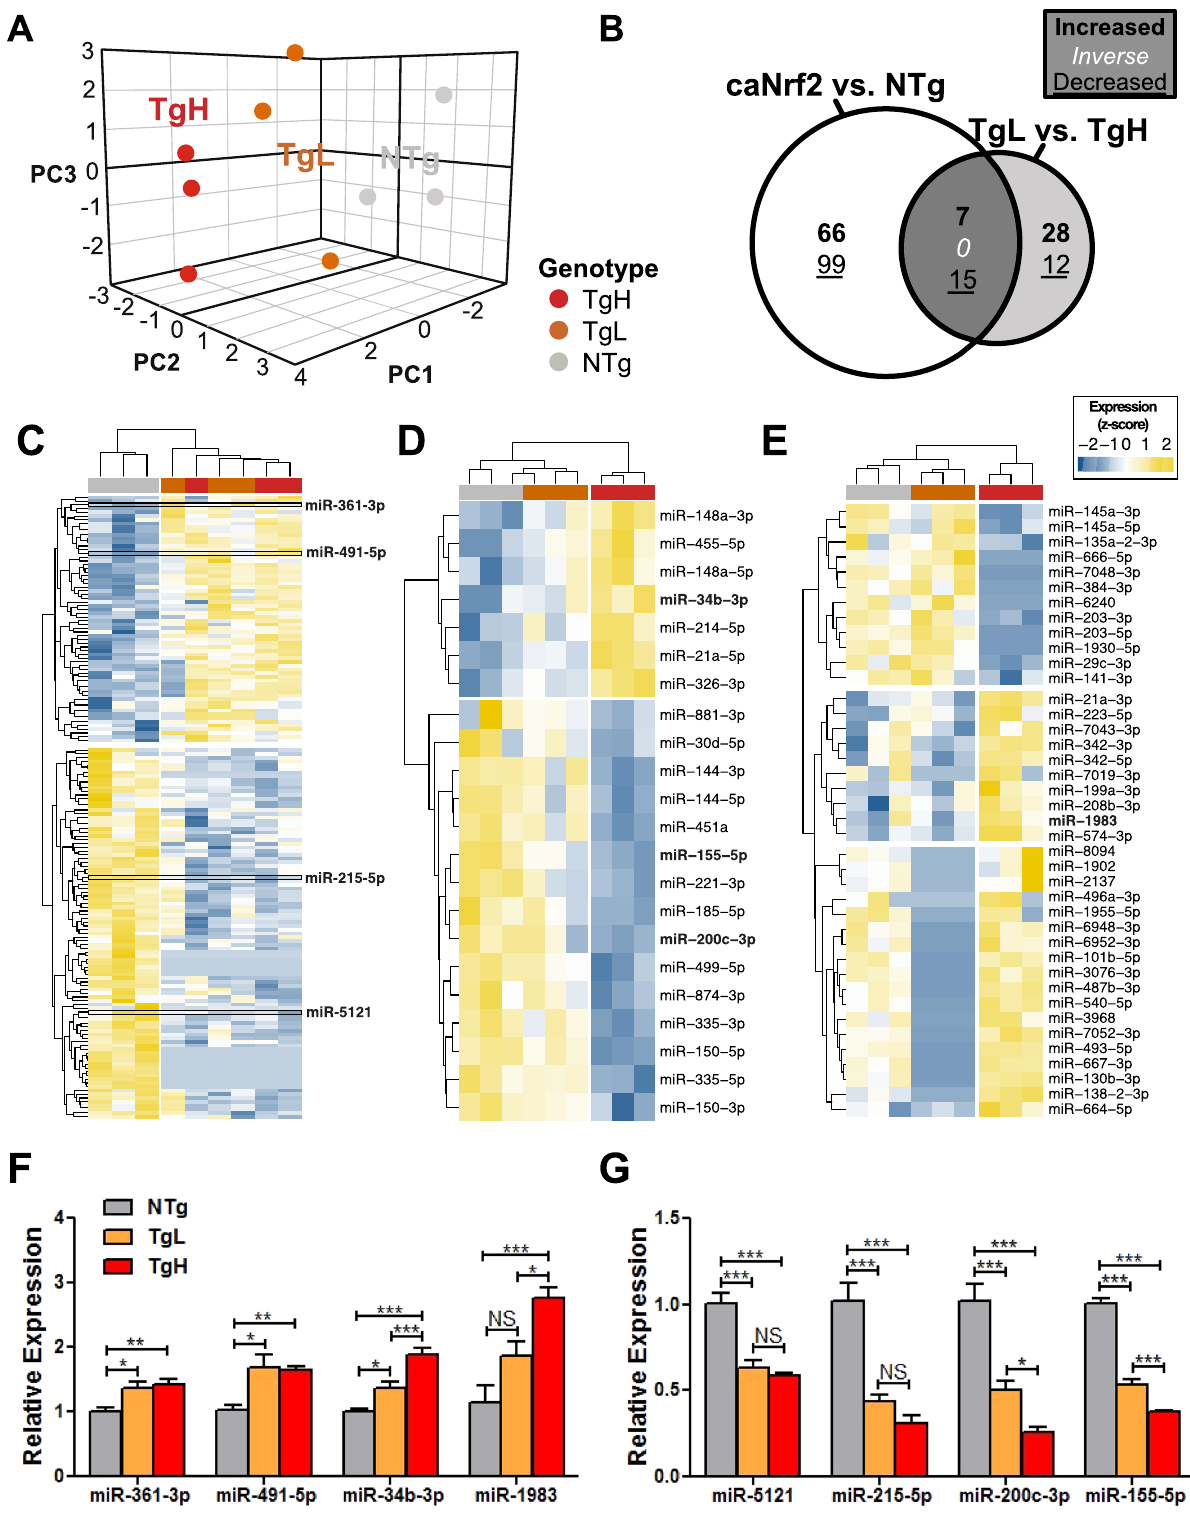
Figure 2. miRNA Sequencing Analysis of ca Nrf2 Transgene and Dose Effect. ( A ) Unsupervised three-dimensional principal components analysis of rlog-normalized counts from miRNA-sequencing. ( B ) Venn Diagram illustrating the overlap of differentially- expressed miRNAs (DEmiRs) following pooled transgene-and dose–effect analyses (P < 0.05) (n = 3/group). Hierarchial clustering of variance-stabilized counts according to regions illustrated by the venn diagram, with ( C ) 165 “Transgene-only” DEmiRs (Tables S3 and S4), ( D ) 22 “Transgene-Dose” overlapping DEmiRs (Tables S5 and S6), and ( E ) 40 “Dose-only” DEmiRs (Tables S7 and S8). Highlighted in bold are qPCR-validated DEmiRs. ( F ) Real-time quantitative PCR validation of up-regulated and ( F ) down-regulated DEmiRs from among “transgene-only” ( ↑ miR-361-3p, ↑ miR-491-5p, ↓ miR-5121 and ↓ miR-215-5p), “transgene-dose” ( ↑ miR-34b-3p, ↓ miR-200c-3p and ↓ miR-155-5p) and “dose-only” ( ↑ miR-1983) DEmiRs. Benjamini-hochberg (BH)-adjusted t-test was performed with ****P < 0.0001, ***P < 0.001, **P < 0.01, *P < 0.05 (n = 6–8/group) reported as mean ±